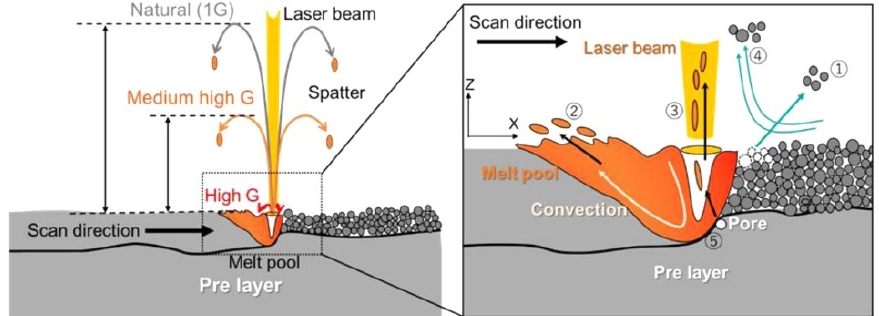
Figure 26. Classification and suppression of spatter under high gravitational acceleration: ① solid spatter; ② metallic ejected spatter; ③ powder agglomeration spatter; ④ entrainment melting spatter; and ⑤ defect induced spatter. (Reprinted with permission from Ref. [139]. Copyright 2021 Elsevier B.V.).